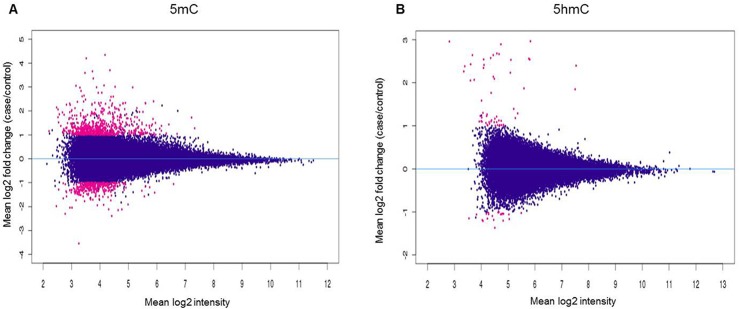
MA plot of Case-Control contrast of (A) 5mC peaks and (B) 5hmC peaks normalized with tag density.The X axis indicates the normalized mean and the Y axis indicates the log2-fold change. Red is used to indicate significantly differently expressed observations (at least 2-fold density changes and p-value<0.05). The blue dots show no differential expression between the two groups.